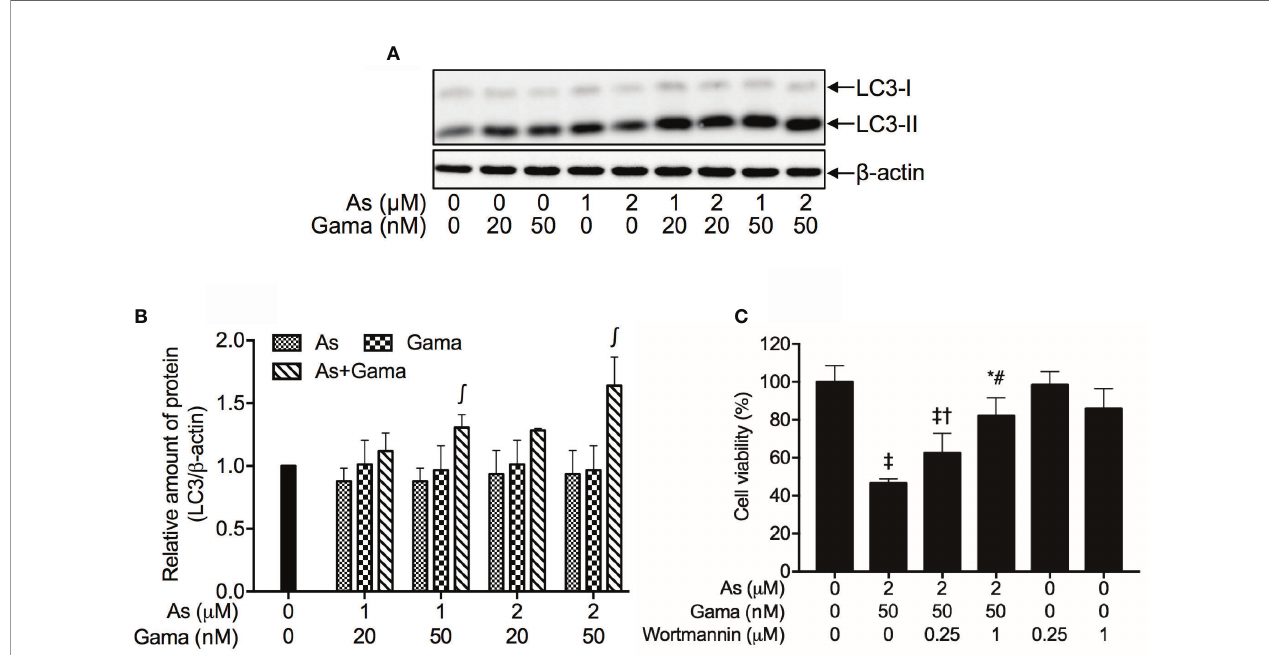
FIGURE 8 | Involvement of autophagic cell death in the cytotoxicity of U-87 cells treated with the combination of As III and gamabufotalin. Following treatment for 48 h with As III (1, 2 m M) and gamabufotalin (20, 50 nM), alone or in combination, the expression pro fi les of LC3 were analyzed using western blotting. A representation image of the expression pro fi le of LC3 is shown from three independent experiments (A) . The expression levels were expressed as the ratio between LC3 protein and b -actin protein expression levels, and were compared with those of control group (B) . Cell viability was determined by XTT assay after treatment for 48 h with the combination of 2 m M As III and 50 nM gamabufotalin in the presence or absence of wortmannin (0.25, 1 m M) (C) . Data are shown as the means ± SD (n ≥ 3). A p value less than 0.05 was considered as statistically signi fi cant ( ∫ p < 0.05 vs. each alone; *p < 0.05; ‡ p < 0.0001 vs. control; † p < 0.05; # p < 0.0001 vs. As+Gama). As, As III ; Gama, gamabufotalin. The images of beta-actin are identical to that in Figure 4B since the same experiment samples were used to